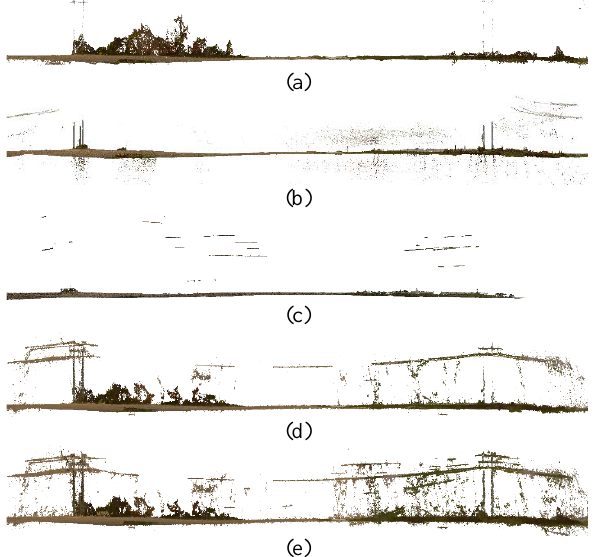
Figure 7. Examples of generated point clouds (side view) for various software packages and image block configurations